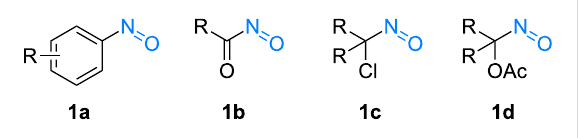
Figure 1: Examples of nitroso dienophiles frequently used in hetero- Diels–Alder reaction studies.